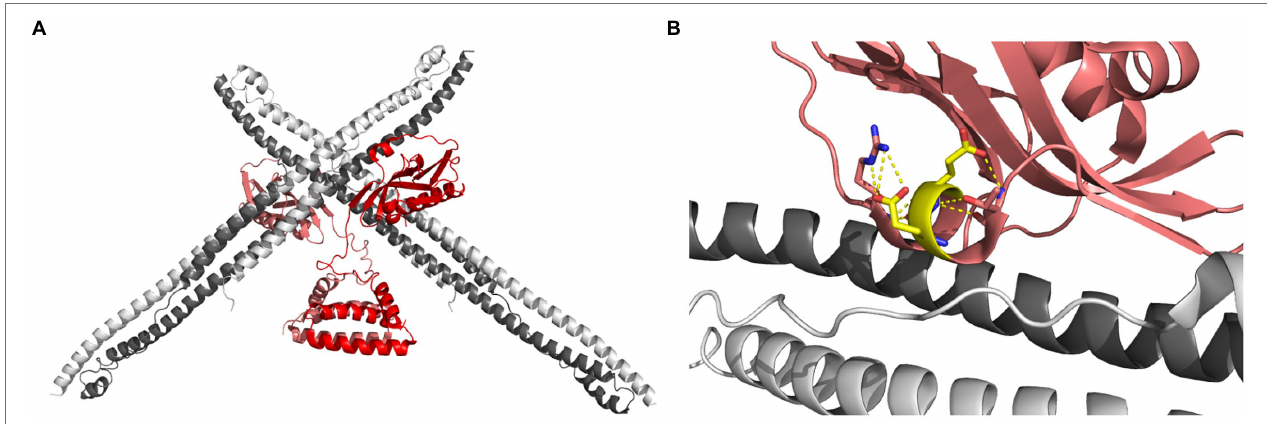
FIGURE 3 | Interaction between NS1 and TRIM25. (A) Crystal structure of the NS1 proteins (red and pink) in complex with four fragments of human TRIM25, each comprising the coiled coil domain (white and dark gray). (B) A view of the NS1 residues E96 and E97 (colored yellow) facing away from TRIM25 and making polar contacts with neighbouring residues. Image was prepared with PyMol using the crystal structure from Koliopoulos et al. (2018; PDB ID: